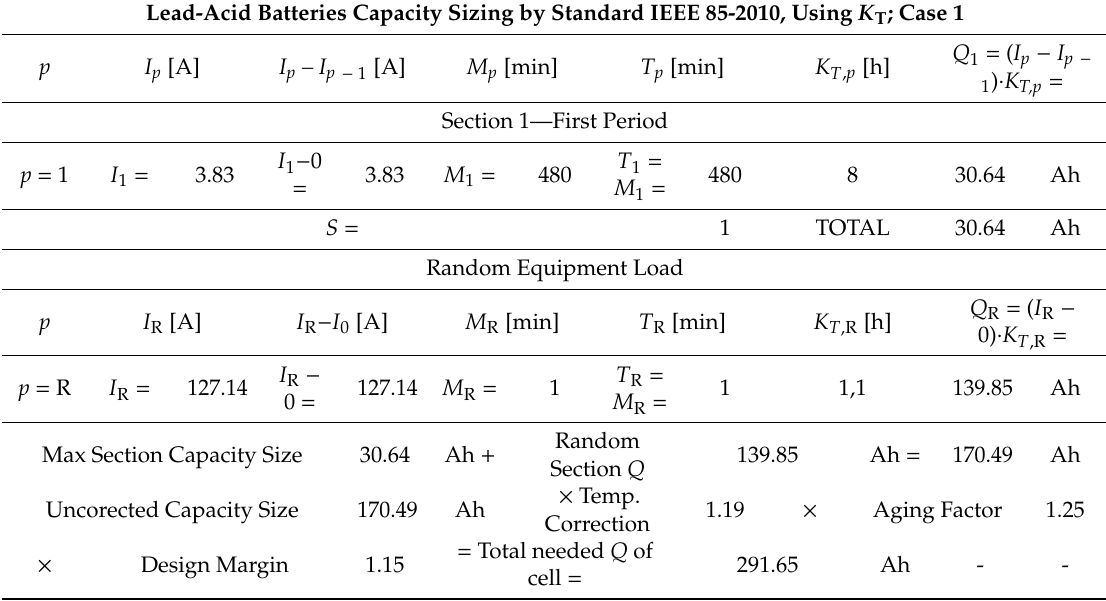
Table 2. Active table for the selection of lead-acid battery capacity for Case